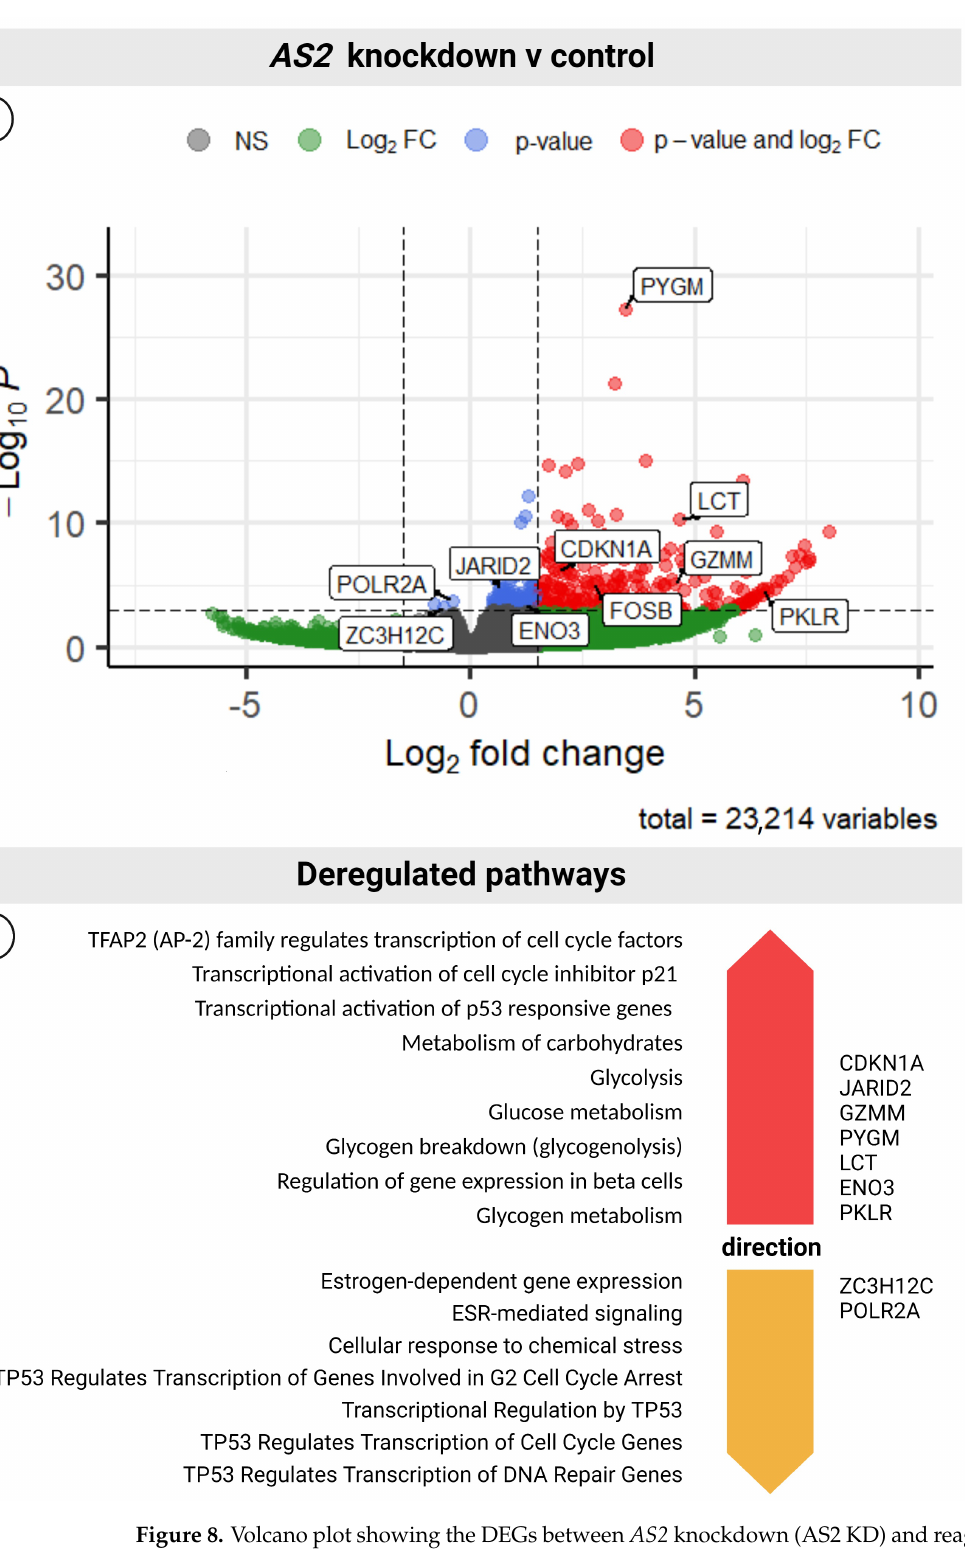
Figure 8. Volcano plot showing the DEGs between AS2 knockdown (AS2 KD) and reagent control ( A ). Pathways which are deregulated upon AS2 knockdown, up regulated pathways shown in orange, down regulated pathways shown in yellow ( B ). Statistical significance for the selection of DEGs was set to padj < 0.001, n = 3. Figure was slylized using